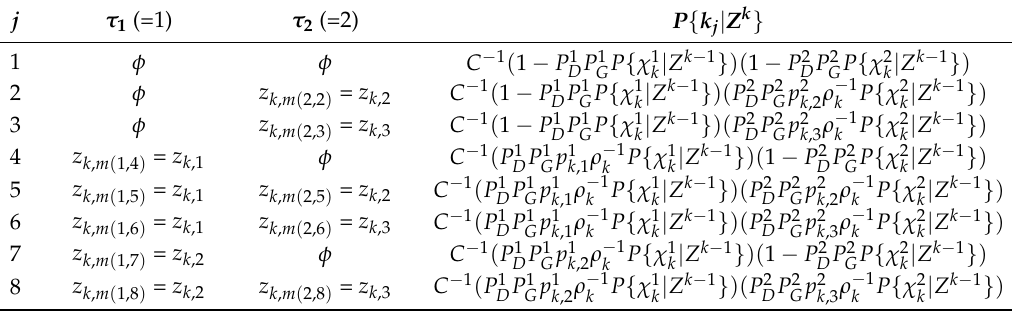
Table 1. Joint event set of the cluster in Figure 1 (‘ φ ’ means no allocation of measurements). j